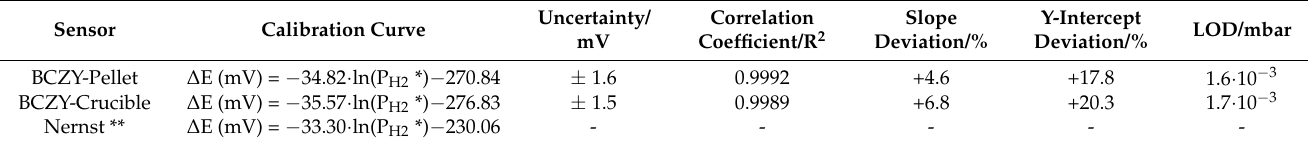
Table 2. Calibration curves of the sensors, deviation from the Nernst equation and LOD at 500 °C.